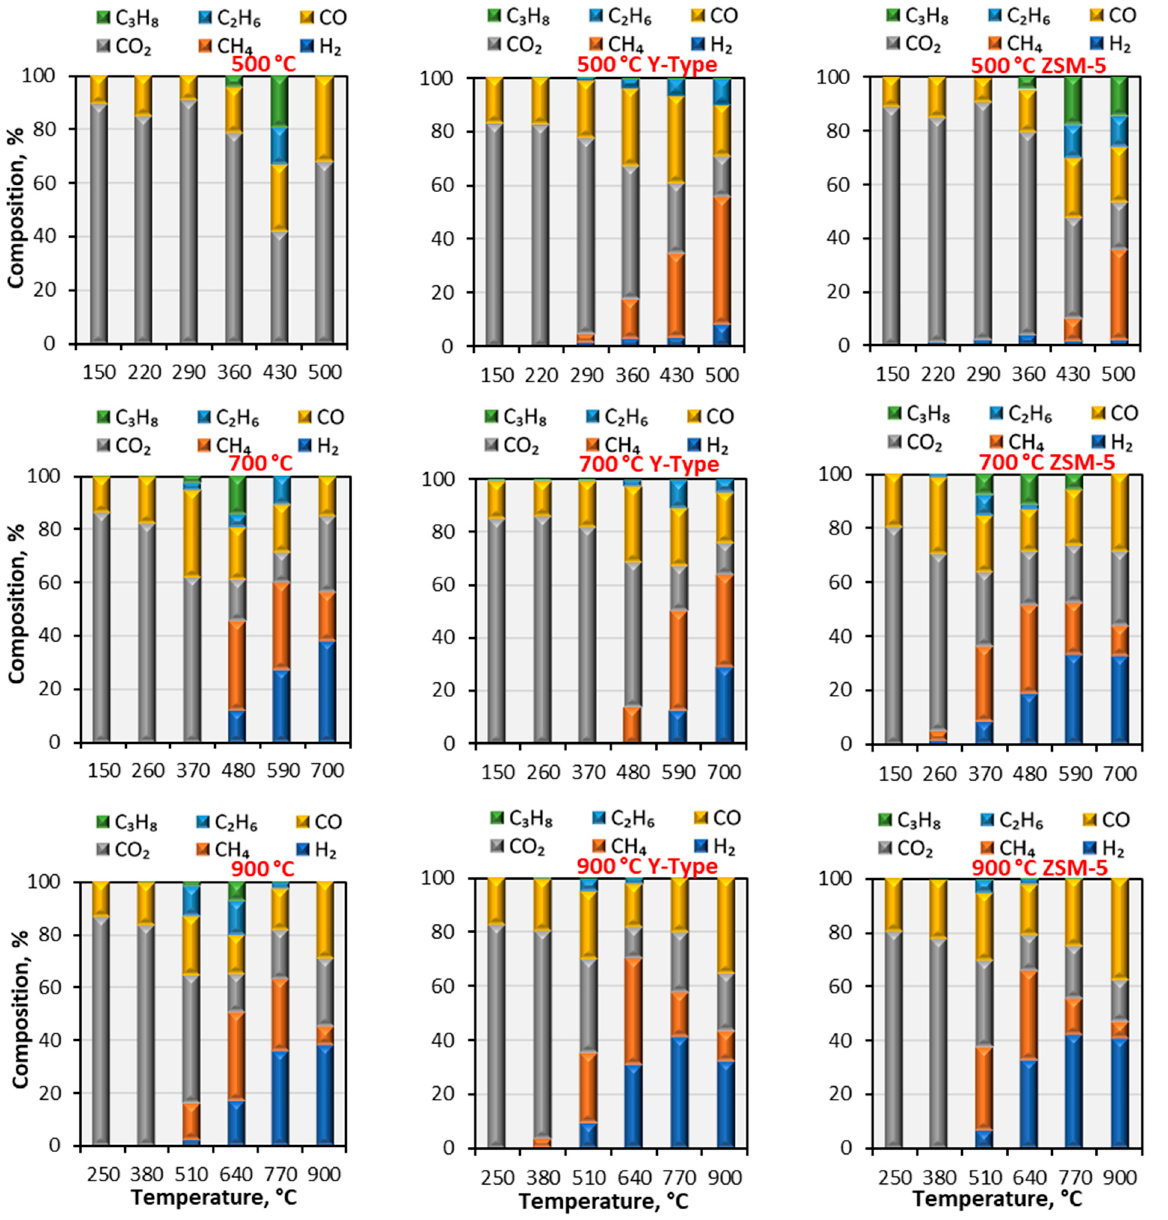
Figure 6. Gaseous product analysis by GC/MS.